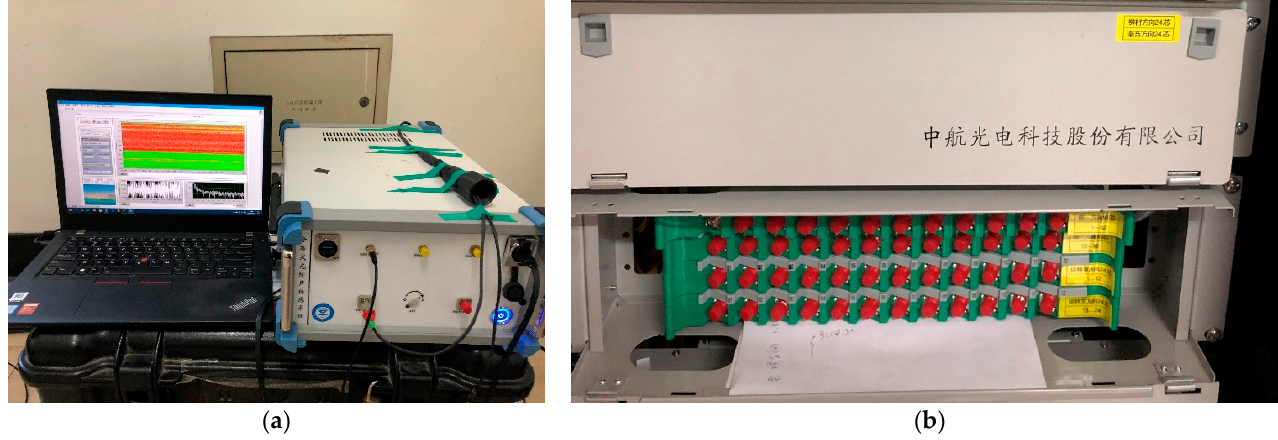
Figure 4. ( a ) The hardware and software of the Φ -OTDR system; ( b ) The sensing fiber-optic cable distribution frame.